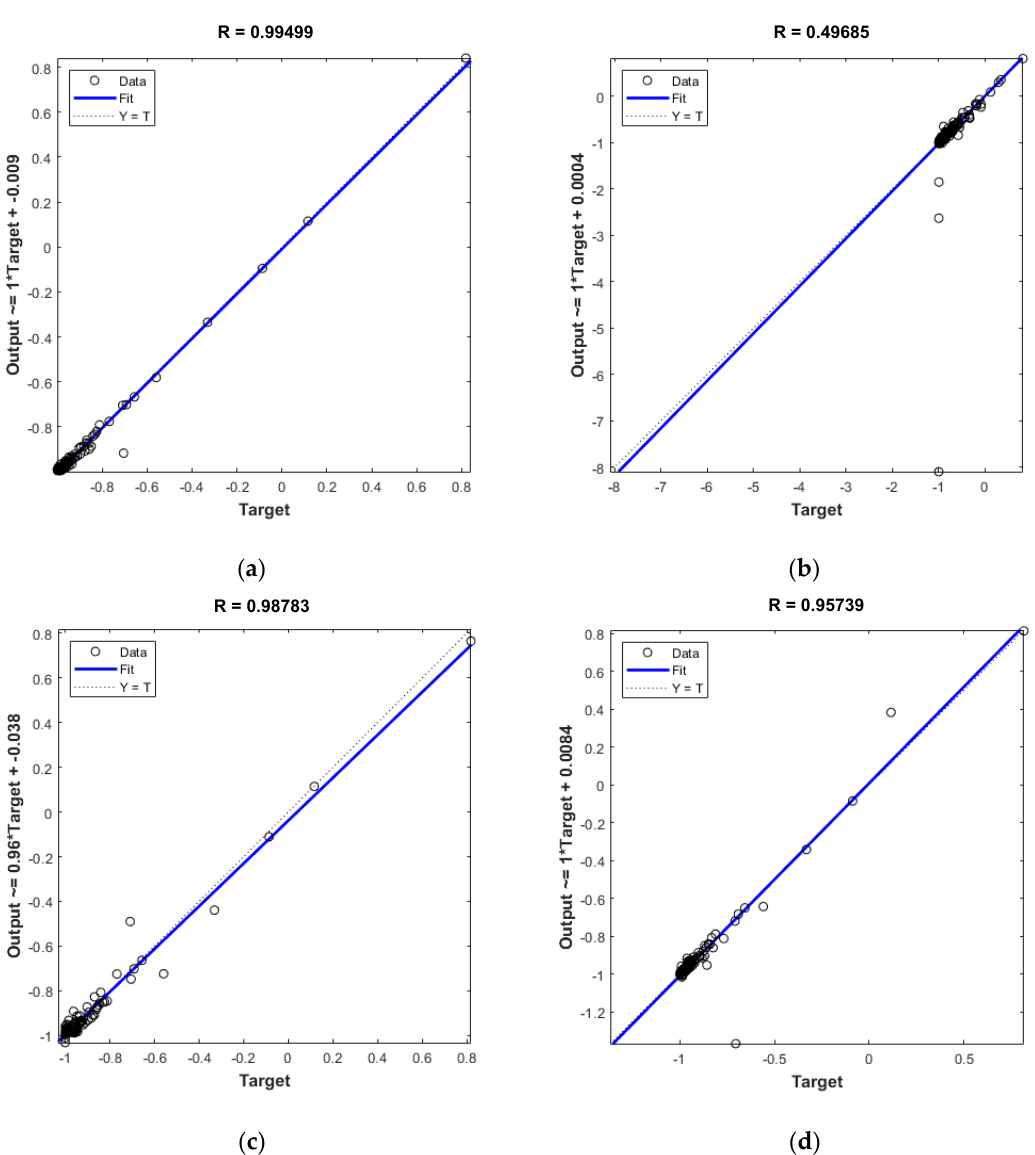
Figure 8. Regression plots of the predictions for the academic case with 68 sensors: ( a ) frequency-dependent ANN, ( b ) NARX, ( c ) ANN with biLSTM layer, and ( d ) pretrained ANN.